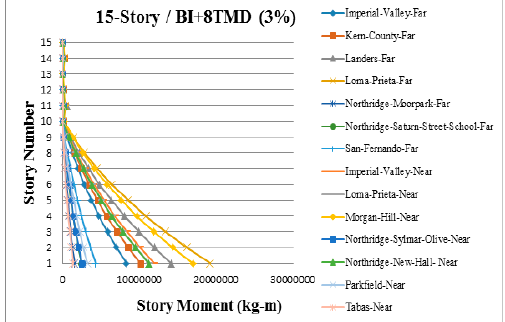
Figure A22. Peak story moments for 15-story base-isolated building with 8 TMDs.